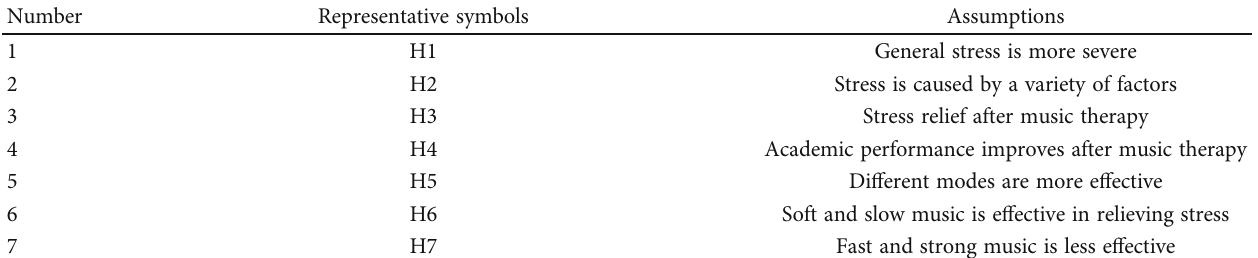
Table 1: Table of study hypotheses.